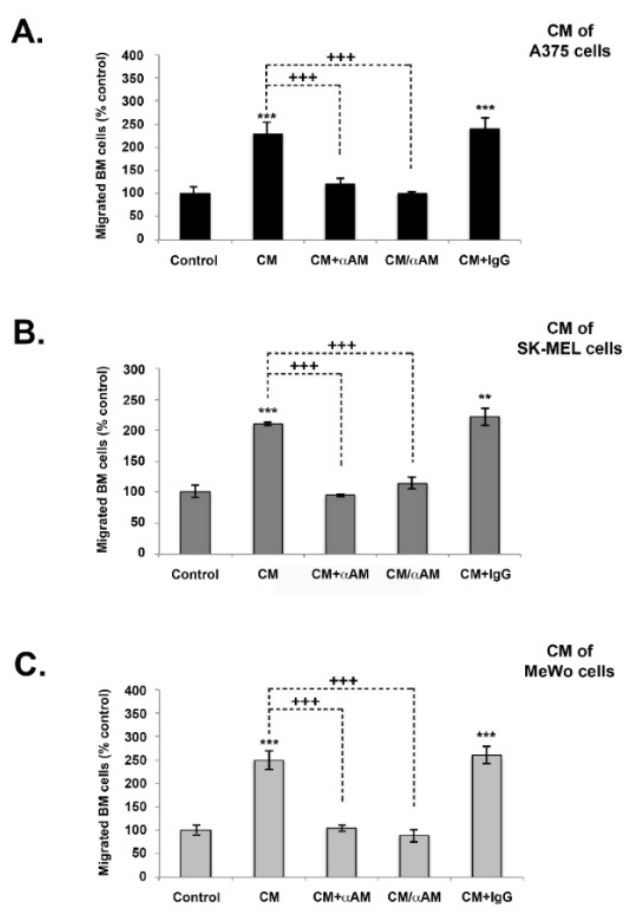
Figure 6. The effect of in vitro melanoma cells-conditioned medium (CM) induced invasion of BMDCs in the AM signaling blockade. ( A – C ) In vitro regulation of BMDCs by A375, SK-MEL-28, and MeWo cells-CM. For all chambers, the bottom well was filled with melanoma cells-CM, while the control well was filled with DMEM containing 2% FBS (control). Immunoreactive AM secreted in CM was neutralized with pretreatment with α AM (70 µ g/mL) for 30 min. α AMRs (70 µ g/mL) or control IgG (70 µ g/mL) was used to pre-treat bone marrow cells (5 × 10 5 cells), which were then placed in the upper chamber and incubated (see Materials and Methods). Migrated cells were stained with DAPI and counted under the microscope at 50 × magnification. Numbers represent the number of migrated cells in 10 high-power fields, given as means ± SD of four independent experiments, each performed in triplicate. The asterisk (*) is used for comparison to control cells (** p < 0.01; *** p < 0.001) and the plus symbol (+) is used for comparison to CM-treated cells (+++ p <